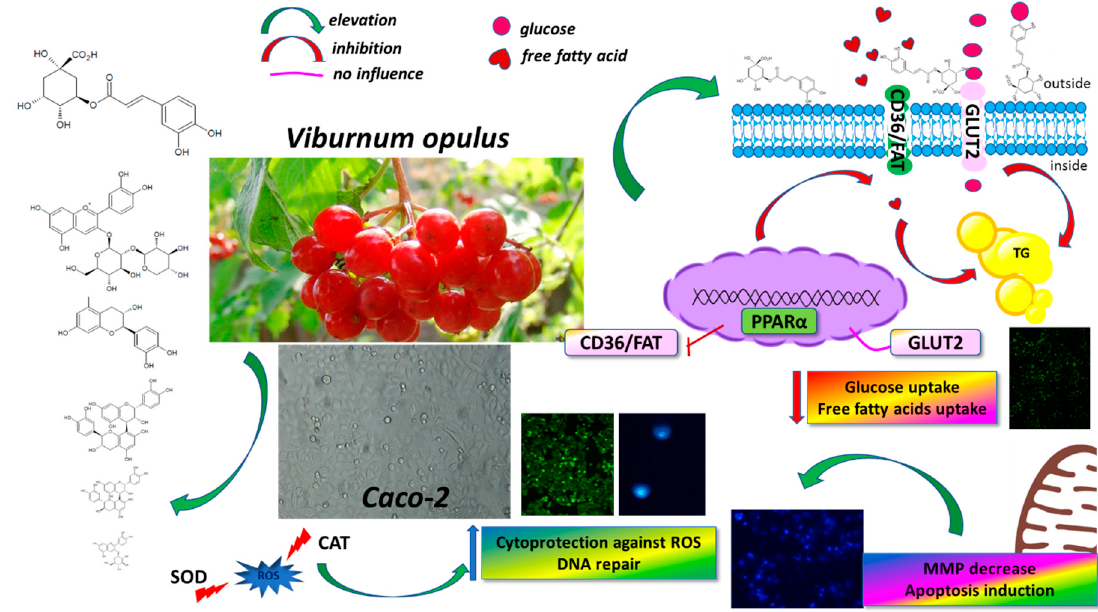
Figure 13. Viburnum opulus phenolic compounds as cytoprotective agents able to decrease free fatty acids and glucose uptake by Caco-2 cells—proposed mechanism of action. They possess cytoprotective activity against ROS generation, stimulate repair of DNA-damaged by mutagens and induce apoptotic type cell death. They are able to attenuate glucose and free fatty acid uptake through inhibition of FFA or glucose transporters. They influence the expression of CD36/FAT transporter, FFA or glucose transporters. CD36/FAT—cluster of differentiation 36/fatty acid translocase CD36/FAT; CAT—catalase; GLUT2—glucose transporter 2; PPAR α —peroxisome proliferator activated receptor α ; ROS—reactive oxygen species; SOD—superoxide dismutase; TG—triglycerides accumulated in adiposomes.